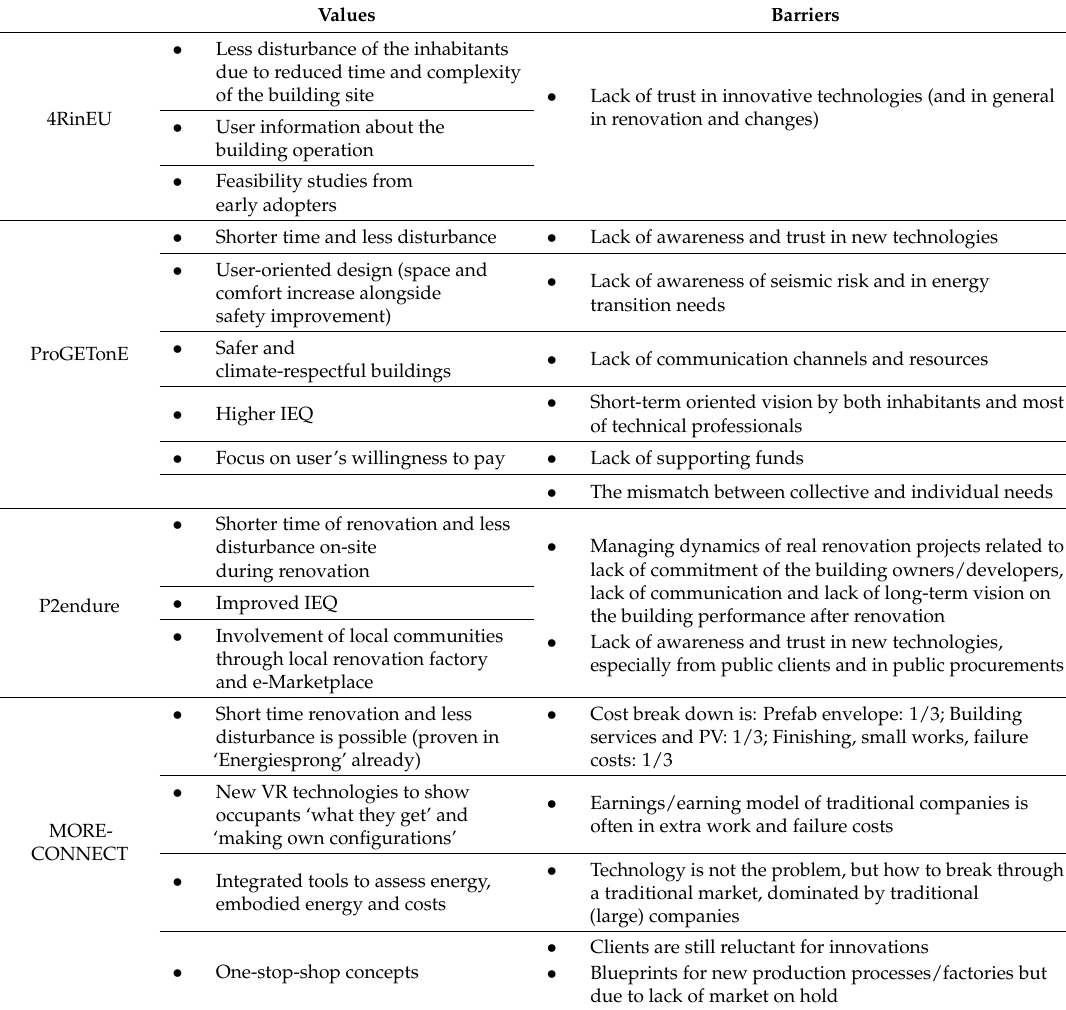
Table 6. Key social added values and barriers emerged from the 4 Cluster